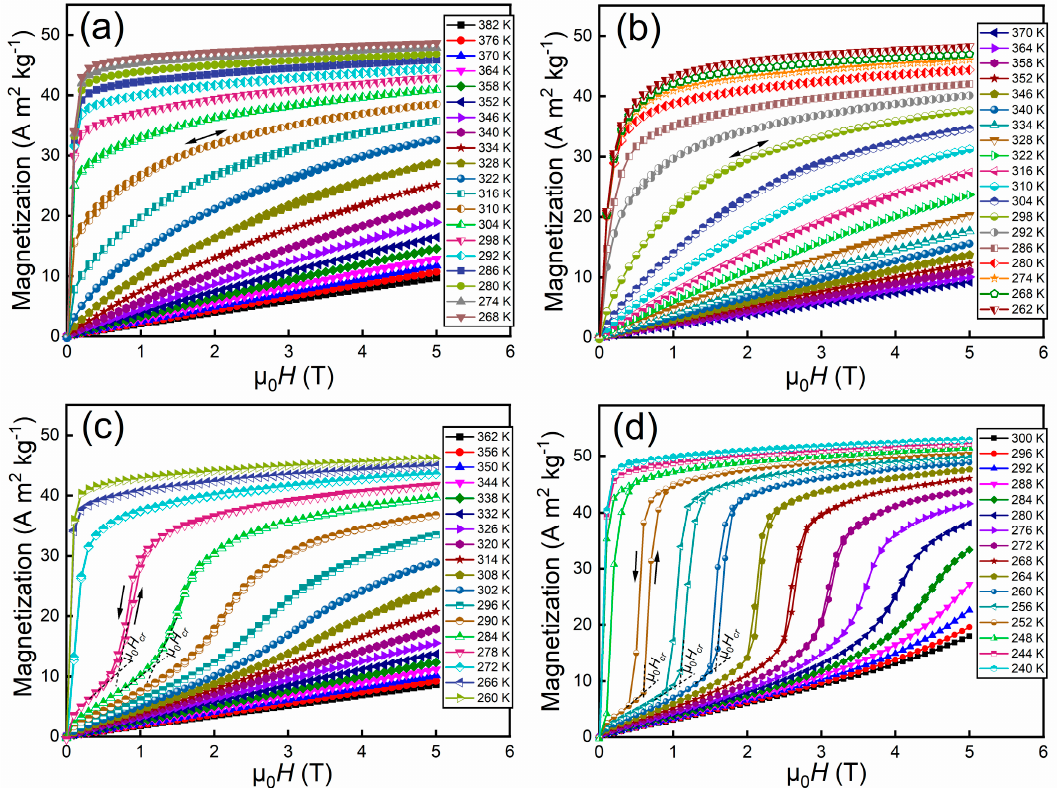
Figure 3. Field-up and field-down isothermal M ( H ) curves for the Hf 1 − x Ta x Fe 2 alloys. ( a ) Hf 0.87 Ta 0.13 Fe 2 ; ( b ) Hf 0.86 Ta 0.14 Fe 2 ; ( c ) Hf 0.85 Ta 0.15 Fe 2 ; ( d ) Hf 0.84 Ta 0.16 Fe 2 .